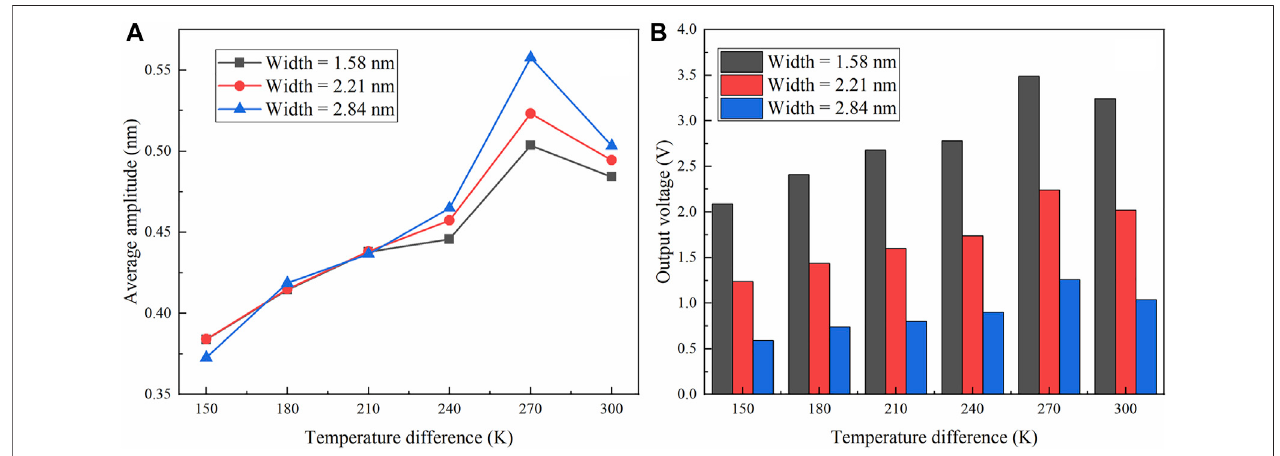
FIGURE 4 | (A) Average amplitude and (B) open-circuit voltage of the MoS